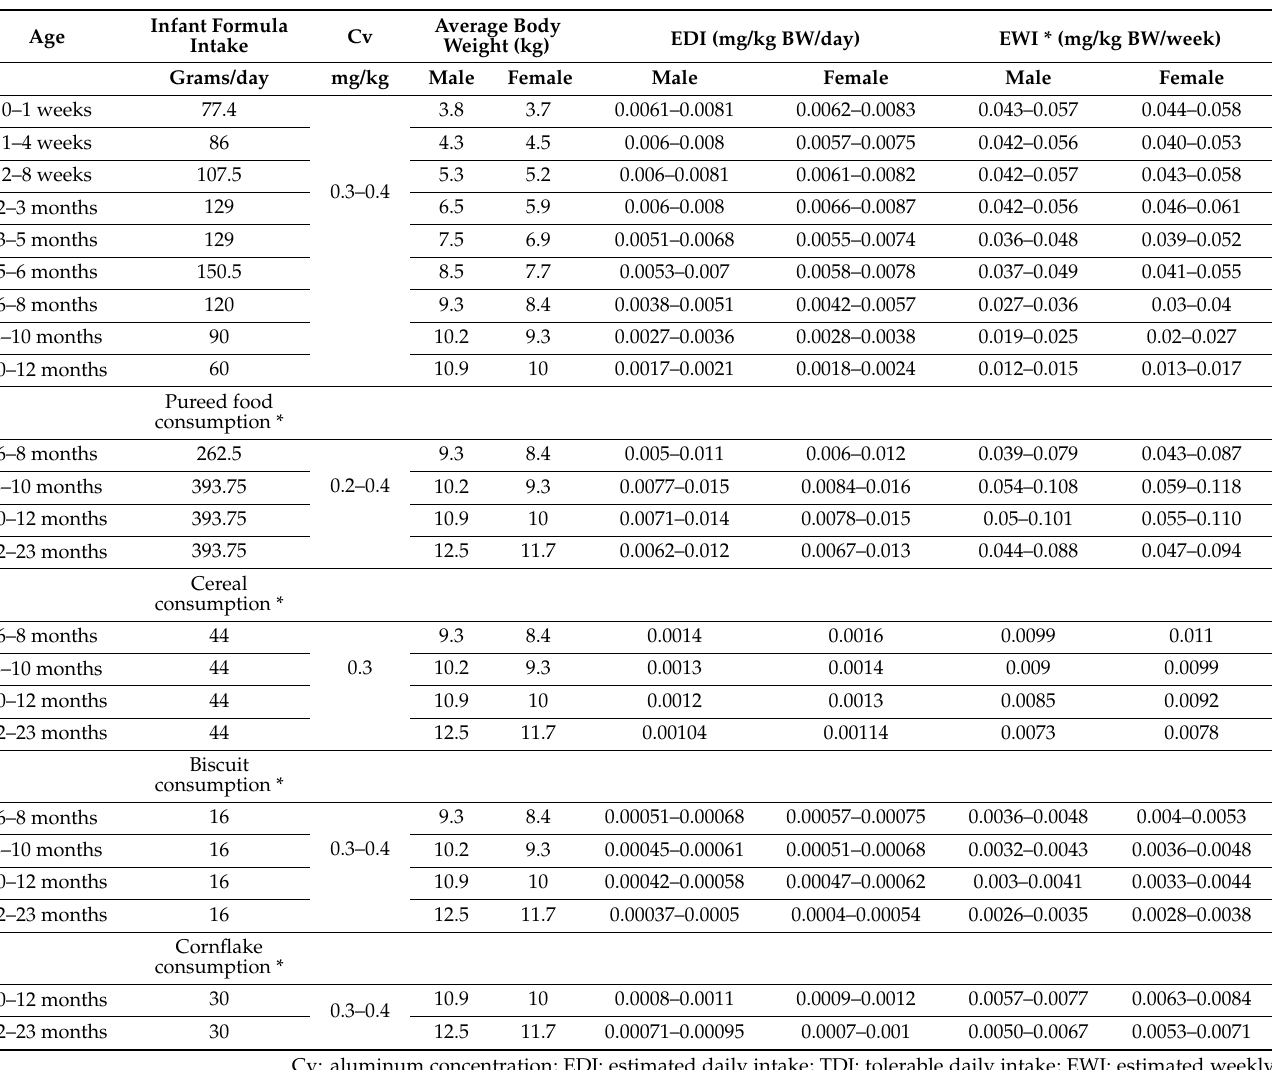
Table 4. Exposure and pediatric health risk assessment to aluminum calculated through EDI and EWI among male and female infants aged under five through infant formula, pureed food, cereal, biscuit, and cornflake consumption at different